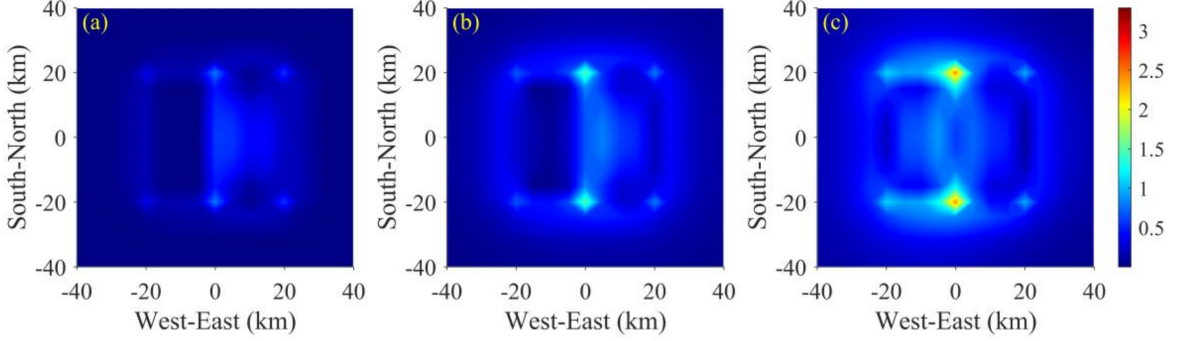
Figure 16. Anisotropy index of COMMEMI 3D-2A model. ( a ) 0.1 Hz. ( b ) 0.01 Hz. ( c ) 0.001 Hz.